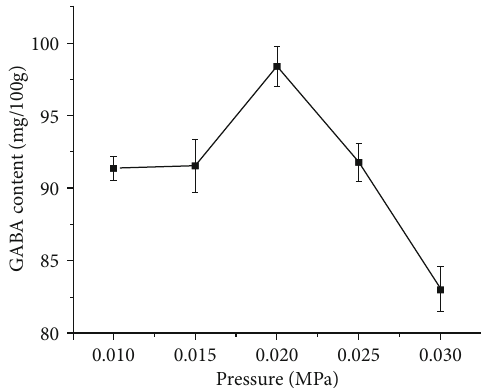
Figure 15: E ff ect of fl ow rate on GABA content.